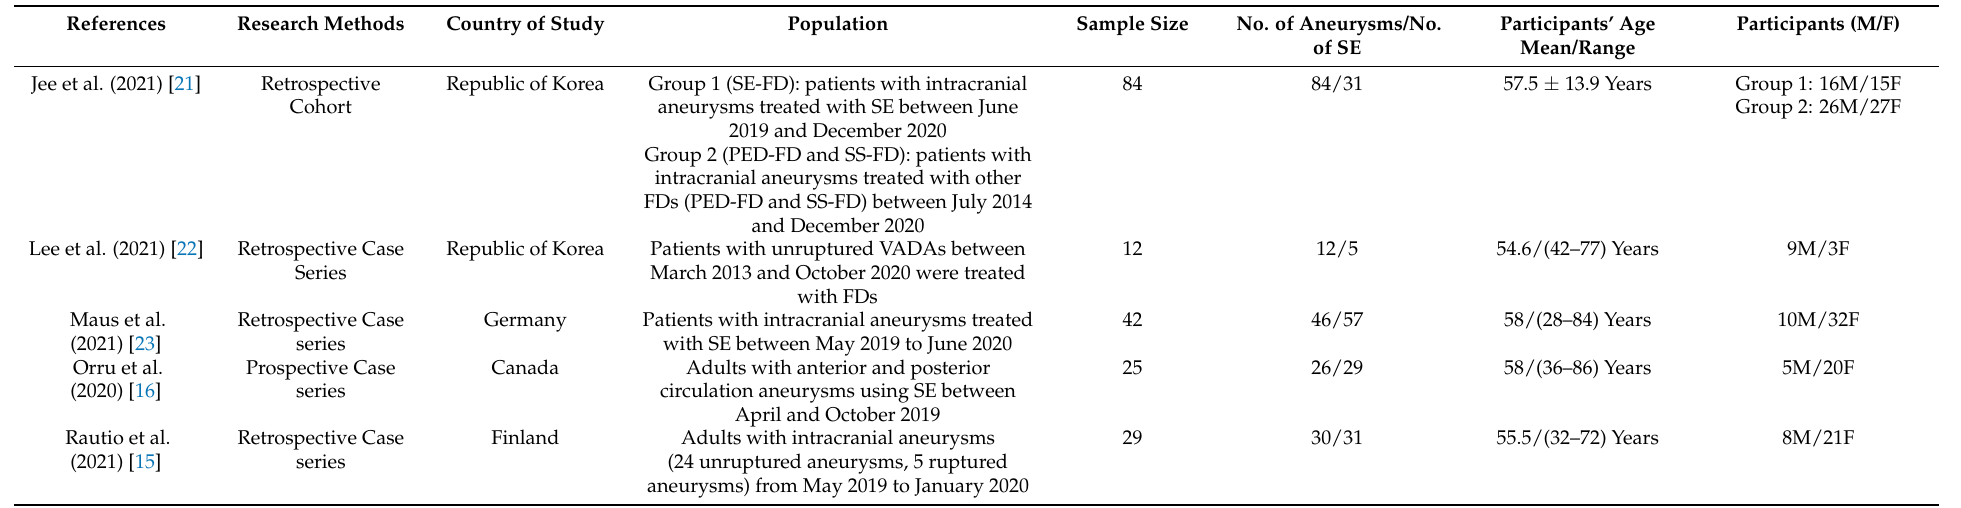
Table 2. Included studies’